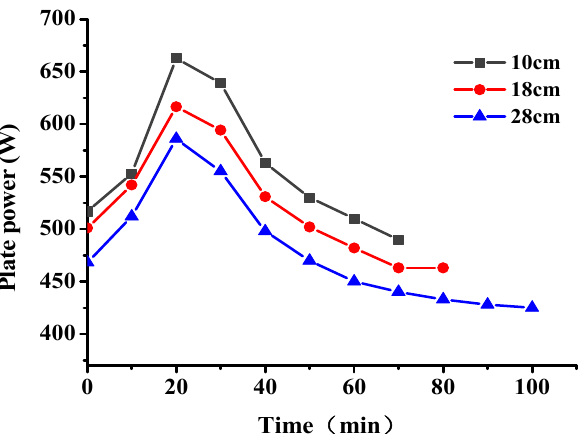
Figure 7. Resistance ( a ) and current ( b ) of graphene composite conductive concrete slabs with different electrode spacings.